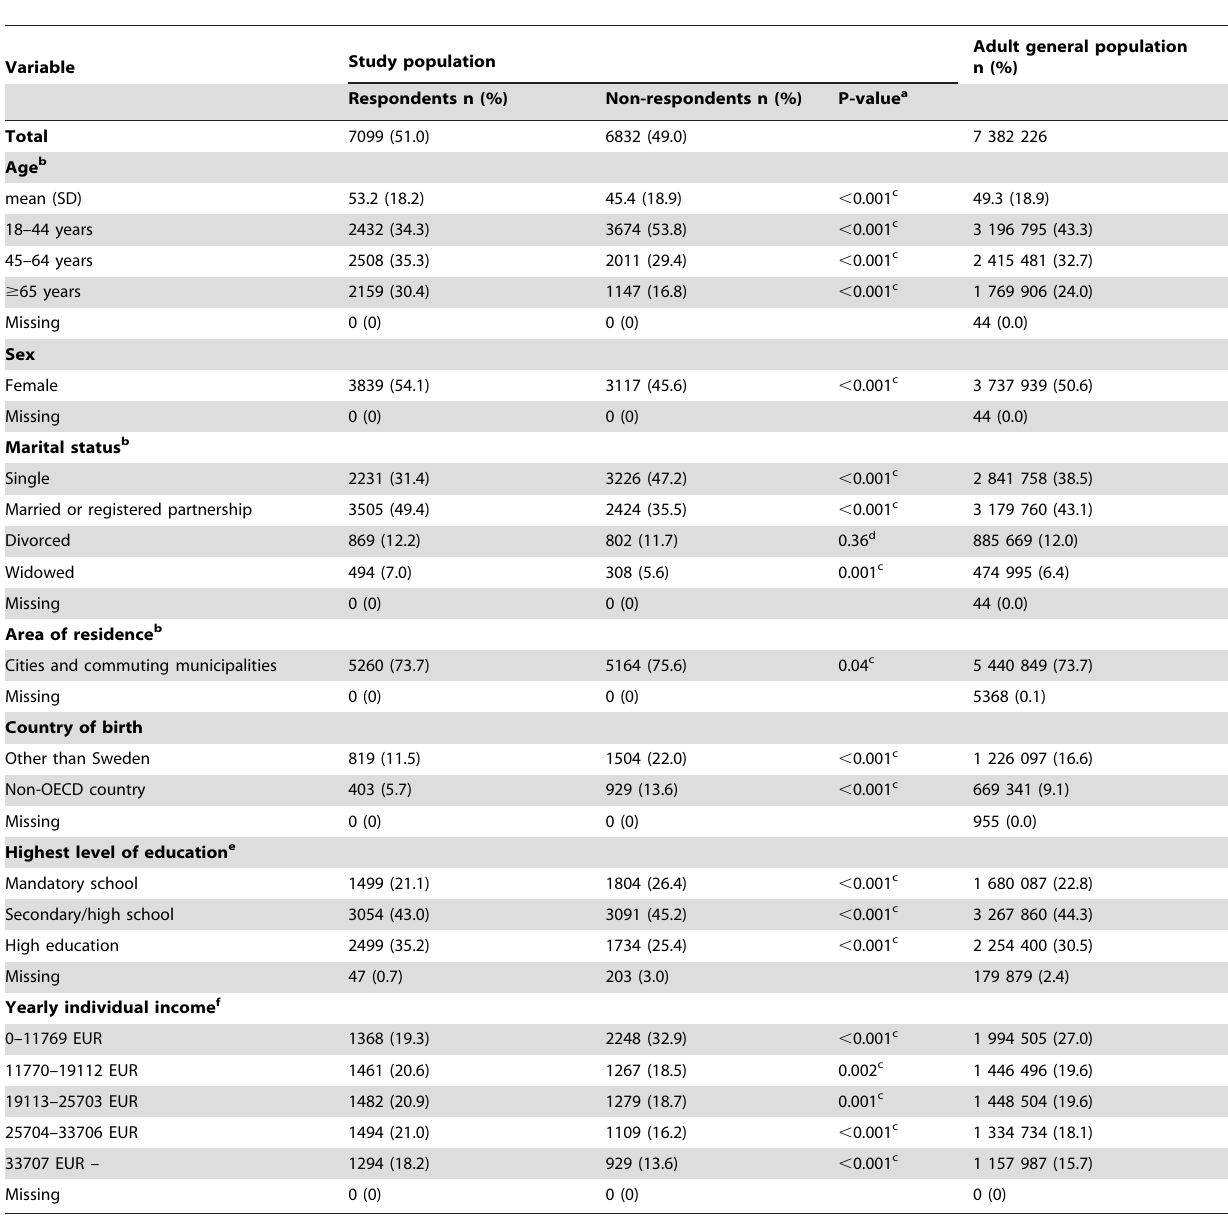
Table 1. Characteristics of the study population (n=13 931) compared to the adult general population in Sweden, retrieved from Statistics